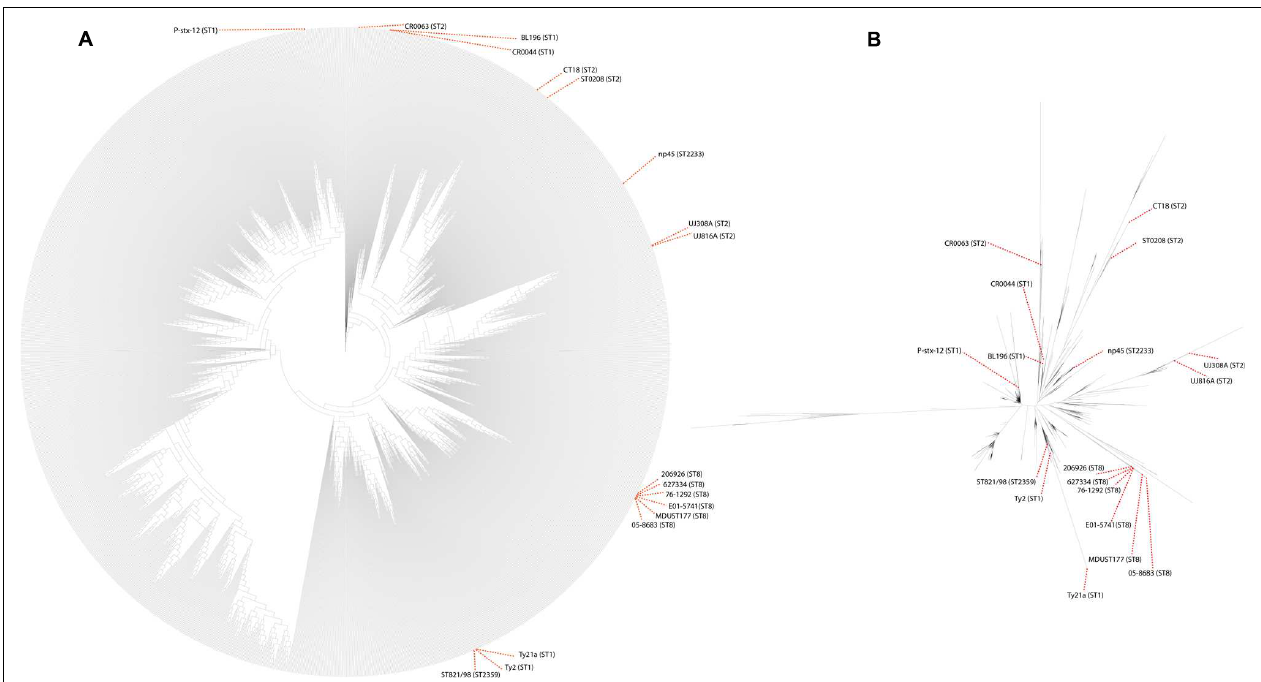
FIGURE 2 | Alignment free-based phylogenomic tree generated from 1,806 S . Typhi and 2 S . Paratyphi A genomes. All reference, our previously sequenced and the uncommon ST-typed genomes with their STs were labeled. Other strain labels were removed to enhance visualization. (A) The phylogenomic tree was rooted with S . Paratyphi A. The node to S . Paratyphi was collapsed (very long branch length) to enhance visualization of the large tree. (B) Unrooted tree generated from 1,806 S . Typhi